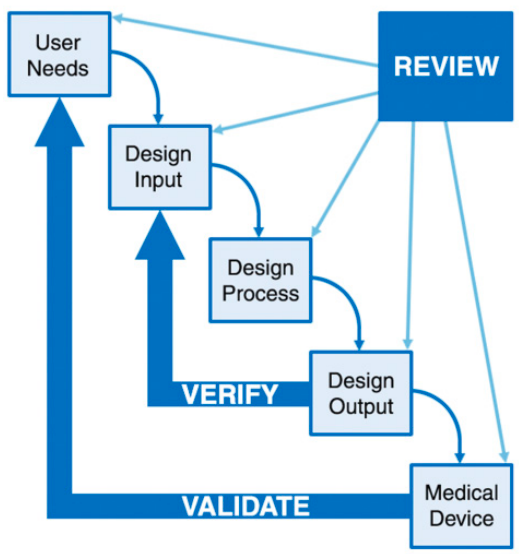
Figure 14. Design control model required for medical device development.